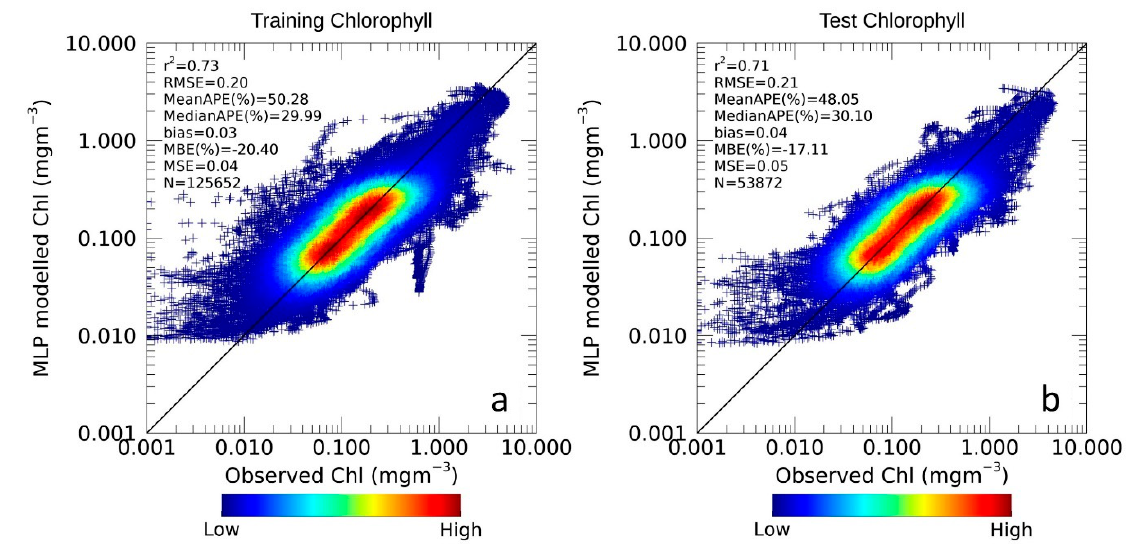
Figure 3. Training ( a ) and test ( b ) results for the MLP chlorophyll predictions. The density scatterplot shows the observed (on x-axis) vs. the MLP predicted values (on y-axis) and their respective statistics. The graphical visualization of the data is in log-scale, while the statistics is computed on linear values. In black, the 1:1 bisector.